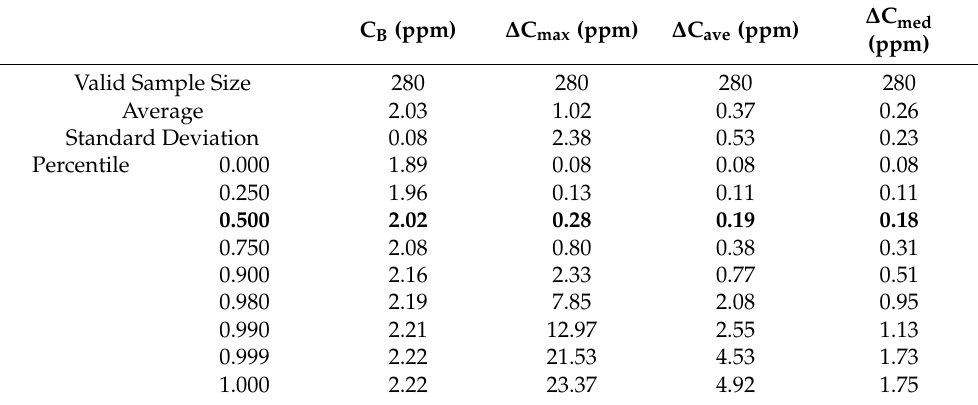
Table 3. Statistics of the 280 peaks detected using parameter set 4 setups for data subset 1. Bolded data represents the